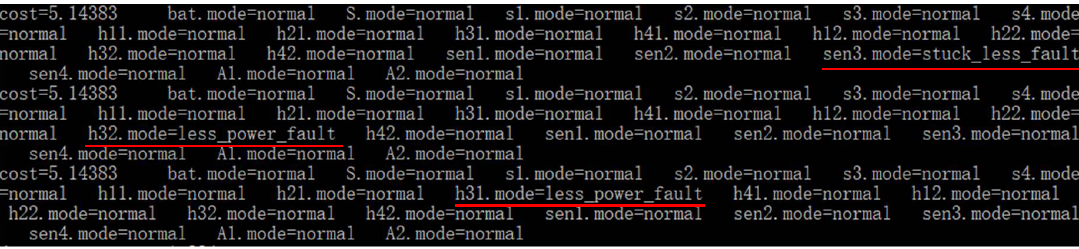
Figure 17. Diagnosis Results of CCDGA* for 3 diagnoses.